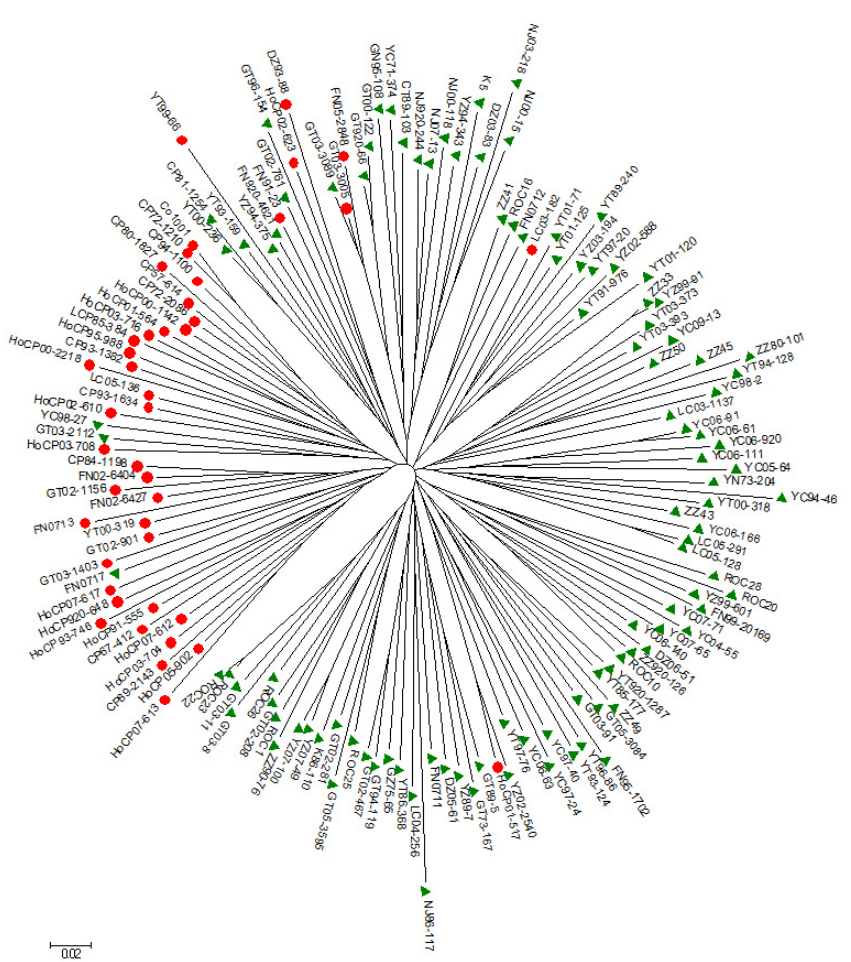
Figure 2. Principal coordinates analysis (PCoA) scatter plots. Red circles represent the Pop1 clones and green triangles the Pop2 clones.